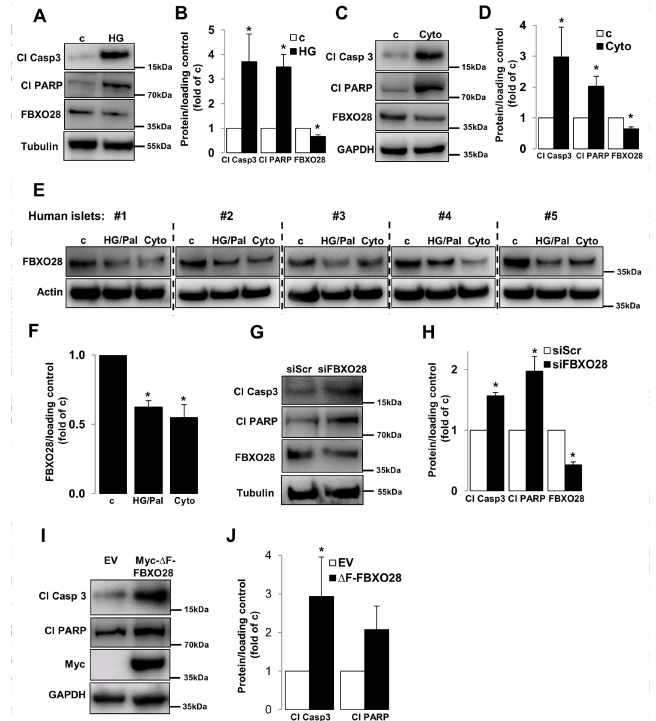
Figure 1. FBXO28 is reduced under diabetic conditions and its knockdown promotes β -cell apoptosis. INS-1E cells or isolated human islets were treated with ( A , B ) 22.2 mM glucose (HG), ( E , F ) the mixture of 22.2 mM glucose and 0.5 mM palmitate (HG/Pal), or ( C – F ) pro-inflammatory cytokines (2 ng/mL recombinant human IL-1 β , and 1000 U/mL IFN- γ ; cyto) or transfected with either control scrambled siRNA (siScr) or siRNA specific to FBXO28 (siFBXO28, G , H ) or with either control empty vector (EV)- or Myc-conjugated ∆ F-FBXO28-overexpressing plasmids ( I , J ) for 2 (INS-1E) or 3 (human islets) days. Representative Western blots of cleaved caspase-3 (Cl Casp3), cleaved PARP (Cl PARP) and FBXO28 protein levels ( A , C , E , G , I ) and pooled densitometric analyses from at least three independent experiments (INS-1E; B , D , H , J ) or six human islet preparations ( F ) are shown. GAPDH or Tubulin or Actin was analyzed to ensure equal protein loading. Data show means ± SEM. * p < 0.05 compared to control